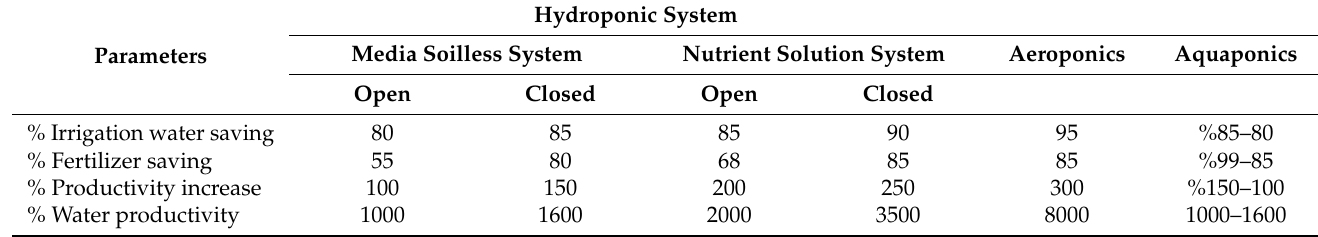
Table 1. Percentage of water and fertilizer consumption, vegetable yield percentage, and the per- centage of water productivity for different new farming systems as compared with the conventional farming system. Reproduced from [55] with permission from American Scientific Research Journal for Engineering, Technology, and Sciences (ASRJETS),